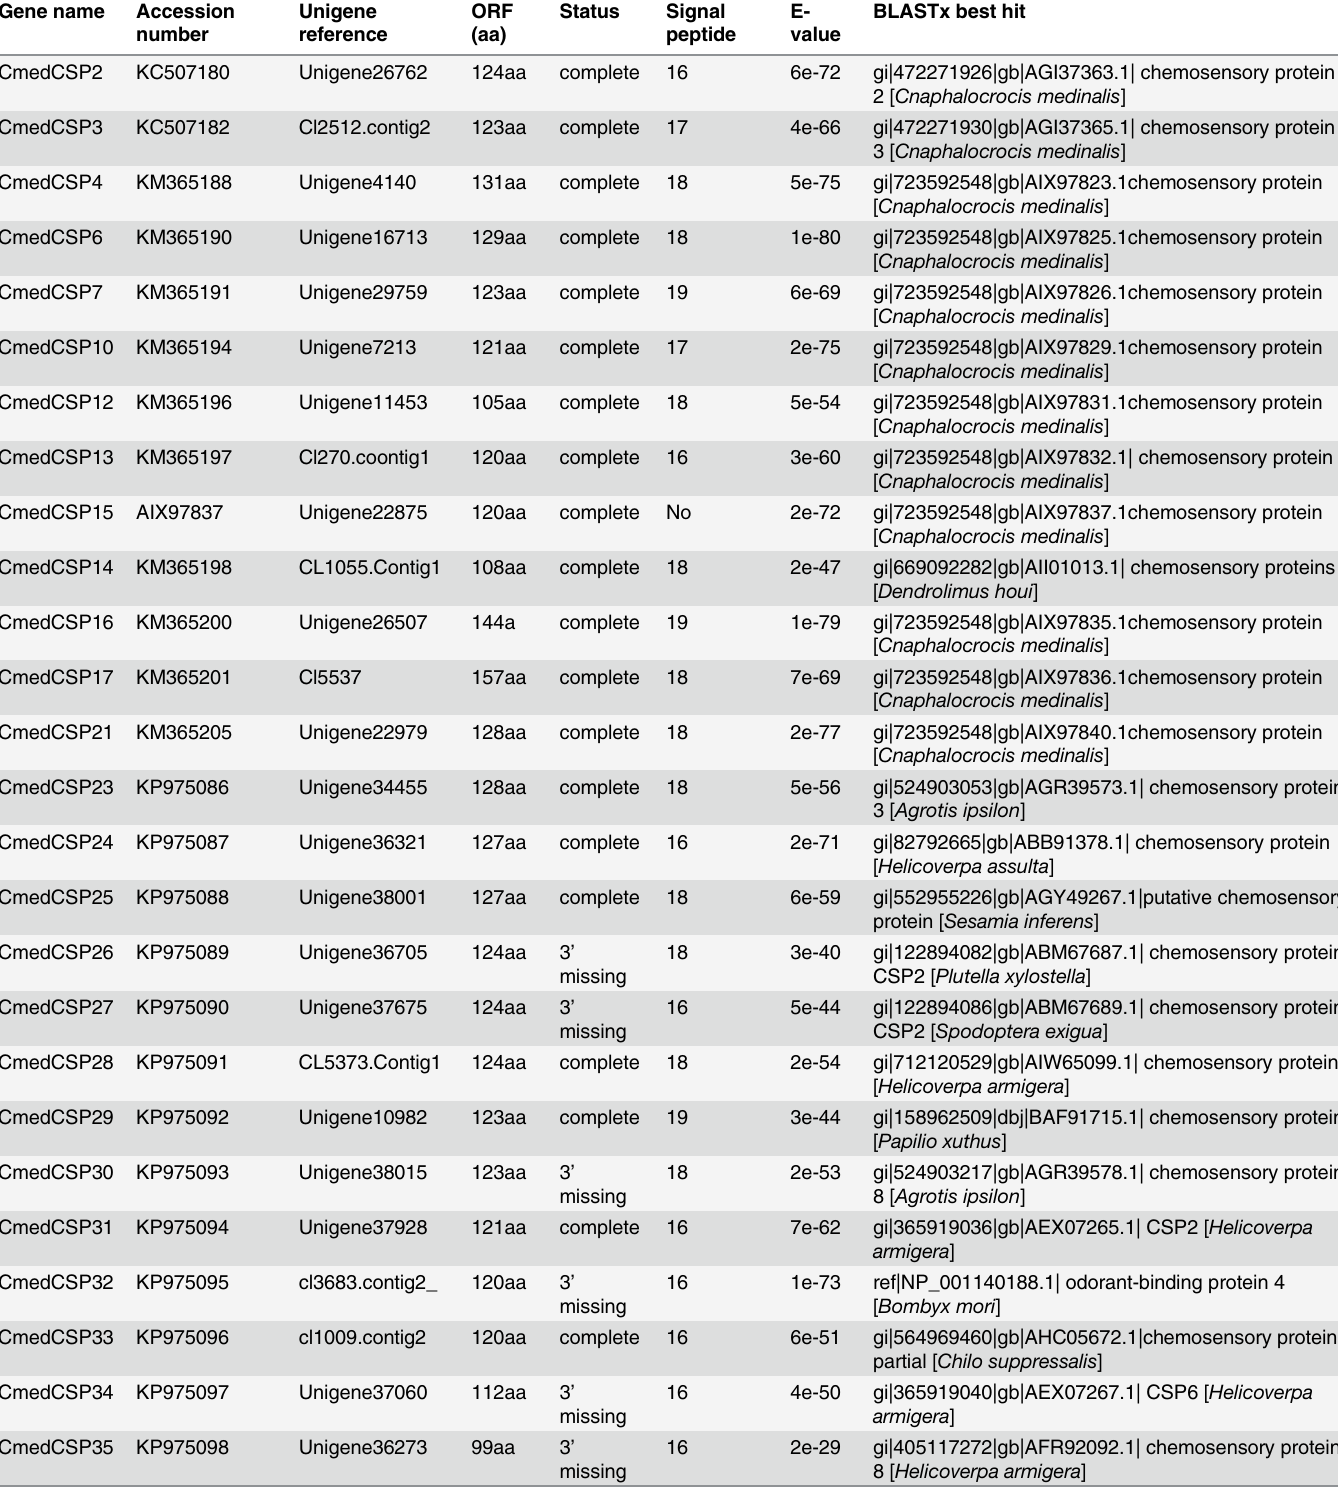
Table 7. Unigenes of candidates for chemosensory